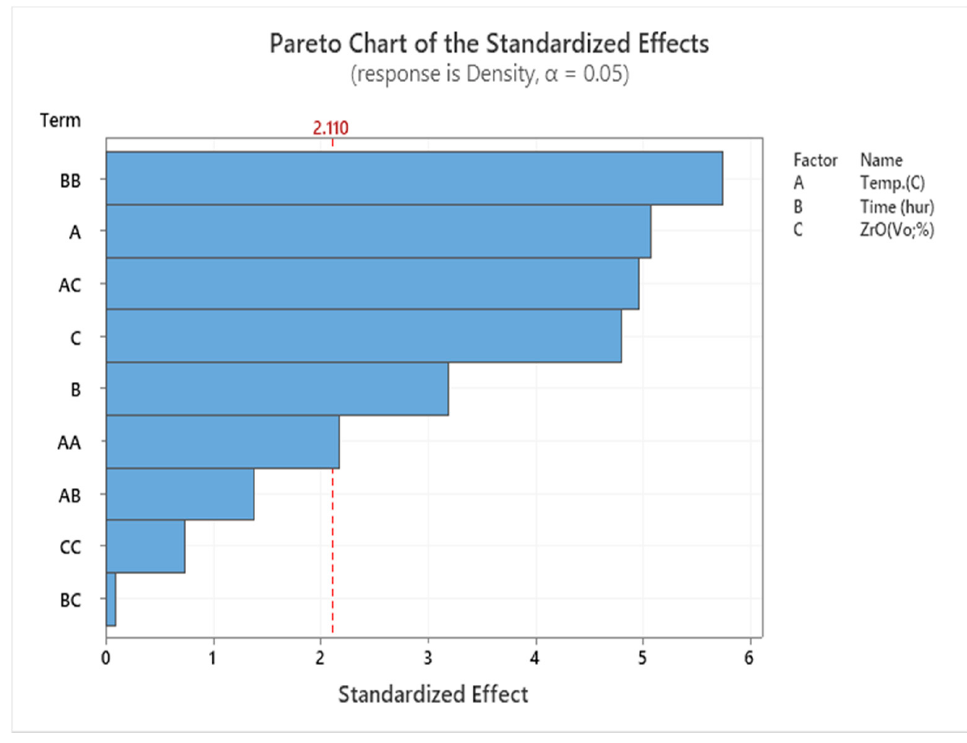
Figure 13. Pareto chart for density.